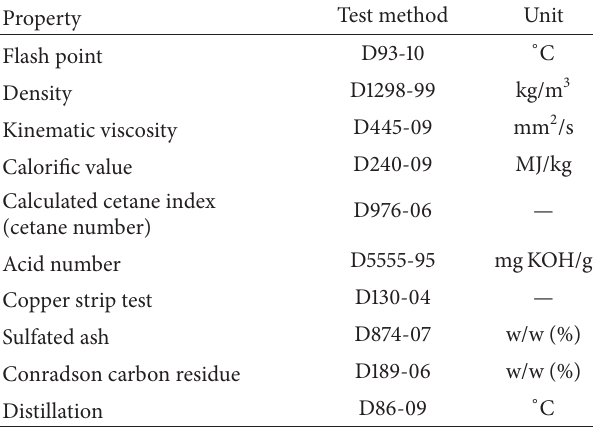
Table 2: ASTM standard test methods used for determination of fuel